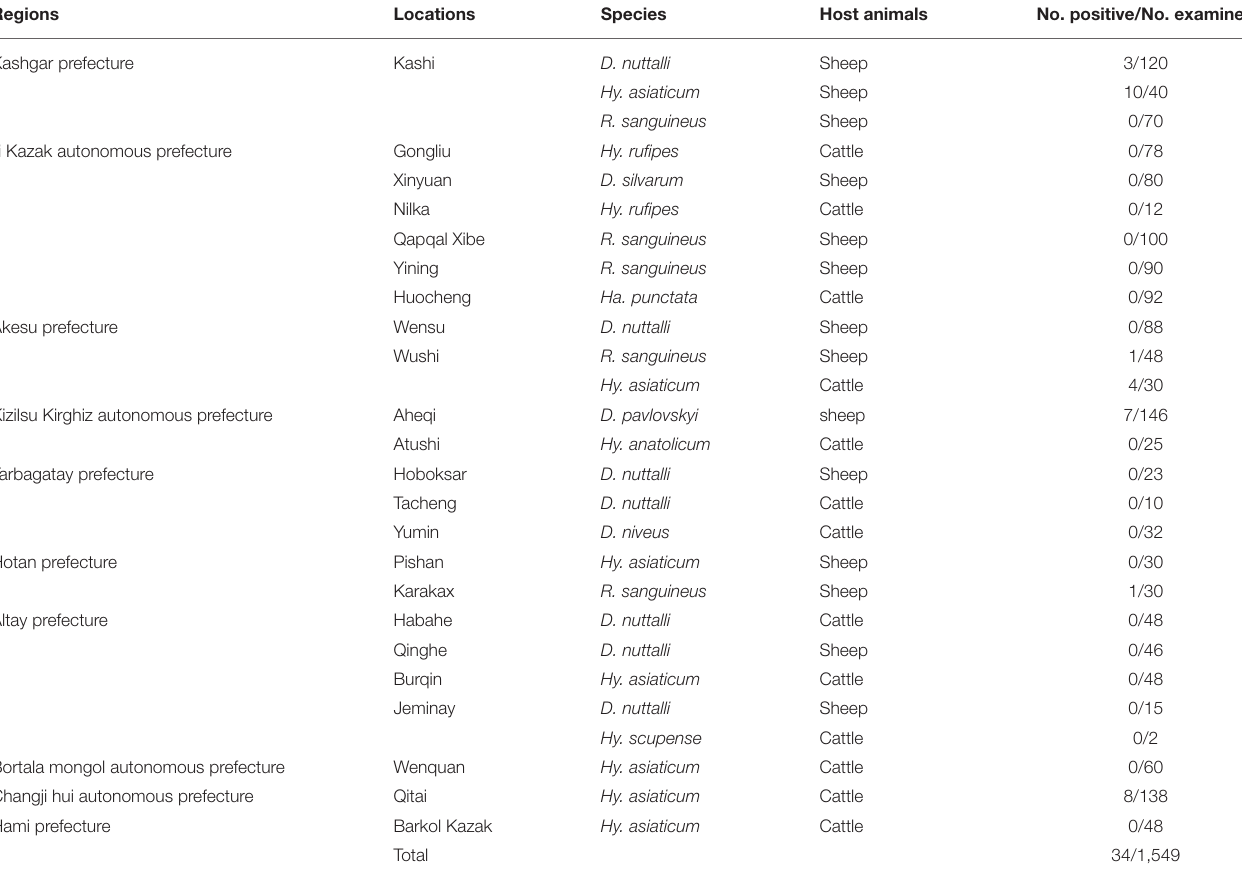
TABLE 1 | Bartonella spp. detection in ticks collected from different localities of the Xinjiang border. Regions